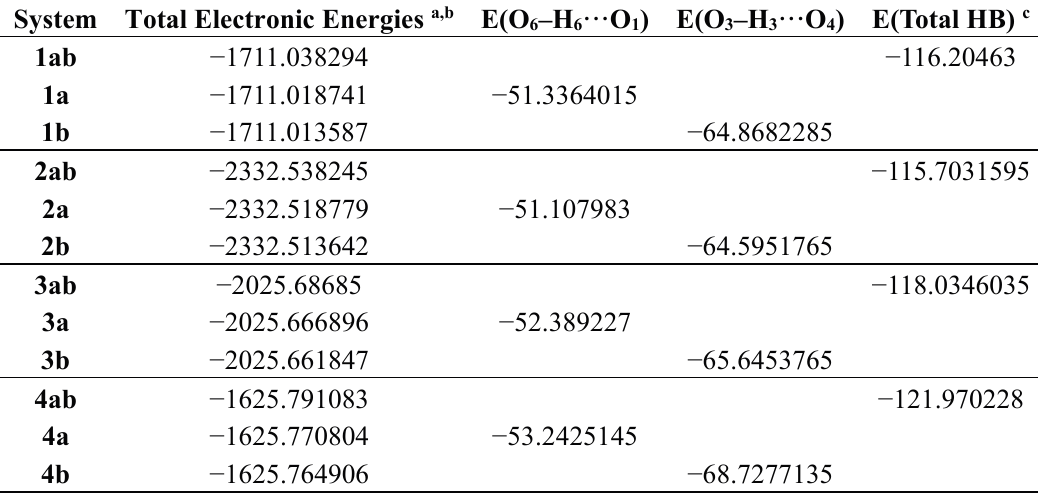
Table 1. Single and total intramolecular hydrogen bonds (HB) energies in biscoumarins 1 – 4 .